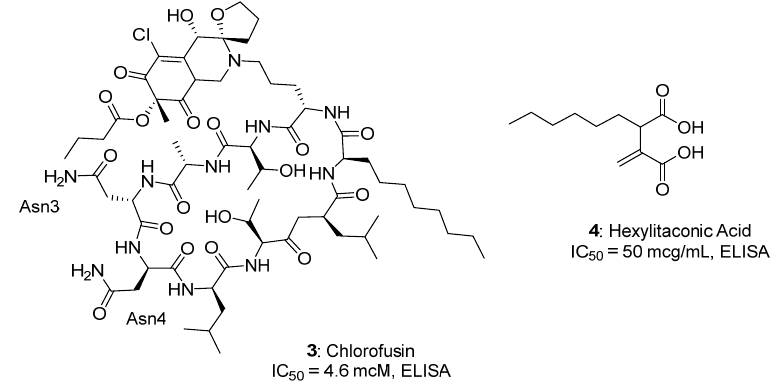
Figure 2. Structures of chlorofusin ( 3) and hexylitaconic acid ( 4) [25–27].